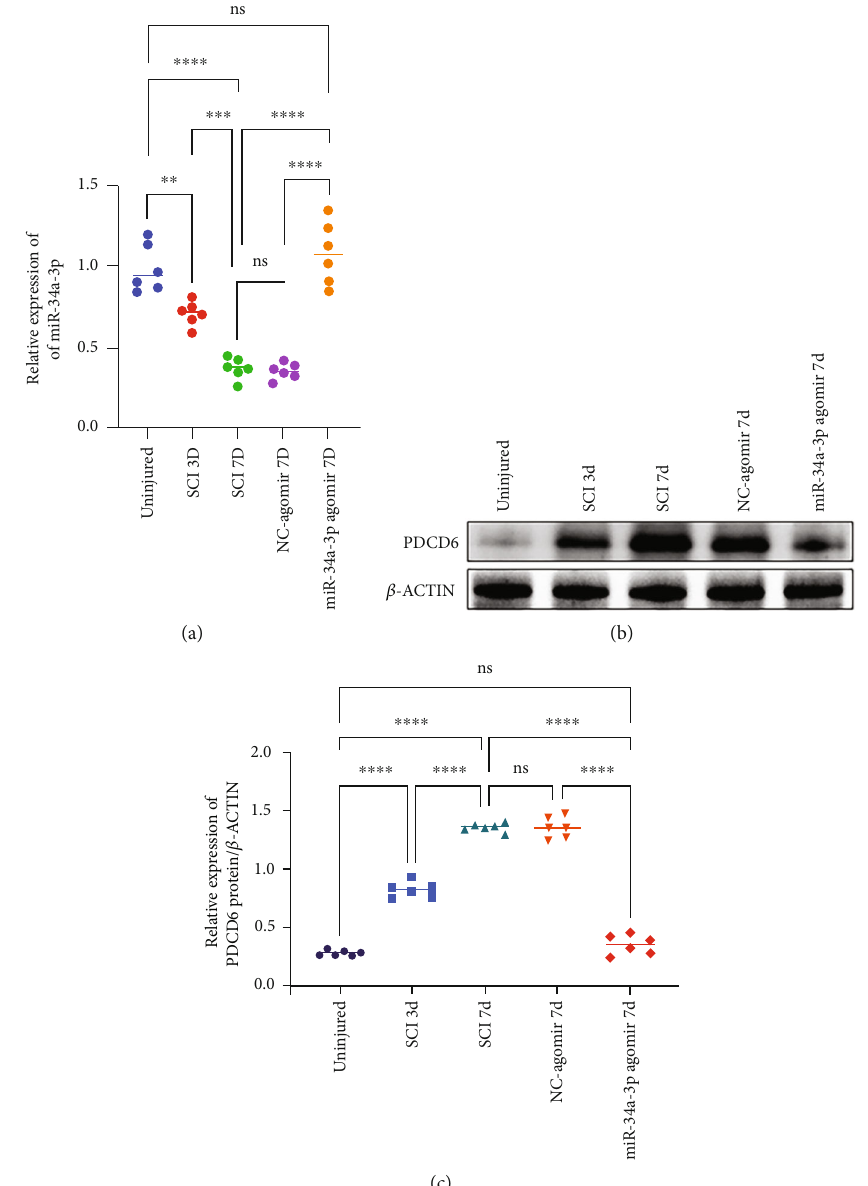
Figure 4: miR-34a-3p e ff ectively facilitated post-SCI axonal regeneration and functional recovery via targeting PDCD6. (a) qRT-PCR quanti fi cation of miR-34a-3p expression at di ff erent post-SCI time points (3 d and 7d); the comparison was also made against forced miR-34a-3p overexpression (as miR-34a-3p dropped markedly at 7d post-SCI). The experiment was performed in triplicate from each of the six animals in each group. The average values obtained from each animal were used in statistical analysis and plotting. (b, c) Western blotting analysis and PDCD6 quanti fi cation in SCI rats. The western blotting analysis and quanti fi cation revealed that PDCD6 expression was elevated in a time-dependent fashion after the induction of SCI; the obvious miR-34a-3p overexpression at 7 d obviously reversed the SCI-induced PDCD6 elevation. Actin was used as an internal control. The experiments were performed in triplicate from 6 di ff erent animals ( n = 6 ). One-way ANOVA followed by Tukey ’ s multiple comparisons test was utilized to identify di ff erences. ∗∗ p < 0 : 01 , ∗∗∗ p < 0 : 001 , ∗∗∗∗ p < 0 : 0001 , and ns: nonsigni fi cant among the compared